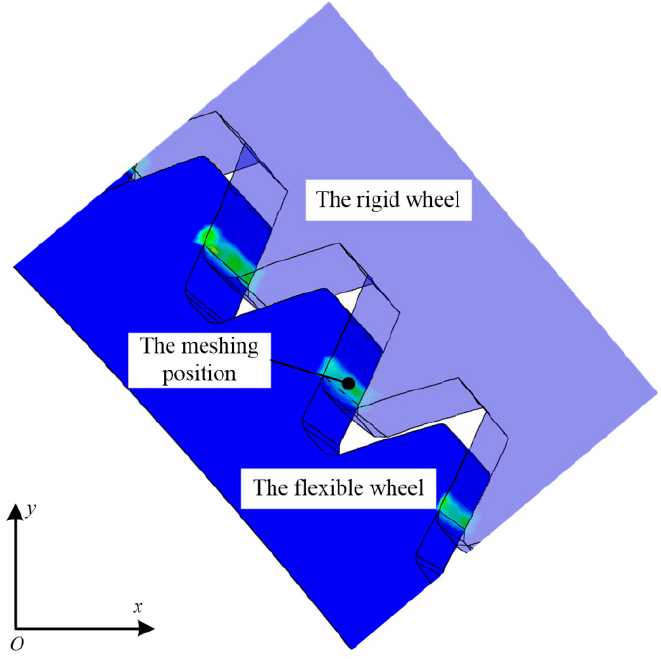
Figure 17. Meshing contact diagram of partial tooth pairs during transmission.